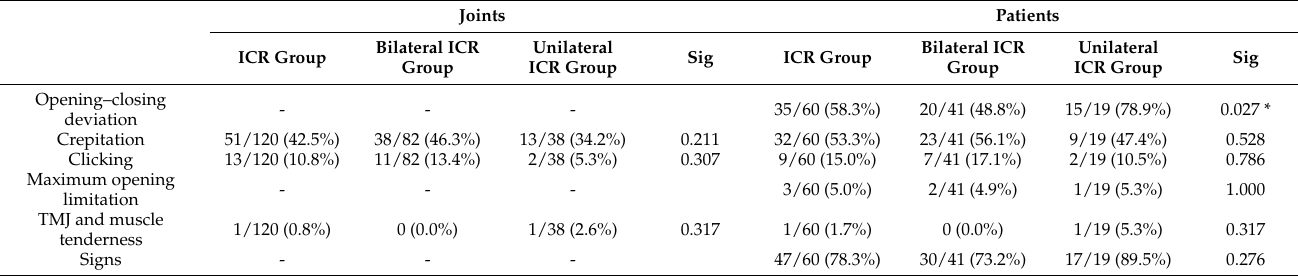
Table 3. Frequencies and percentages of objective-found signs in ICR group.